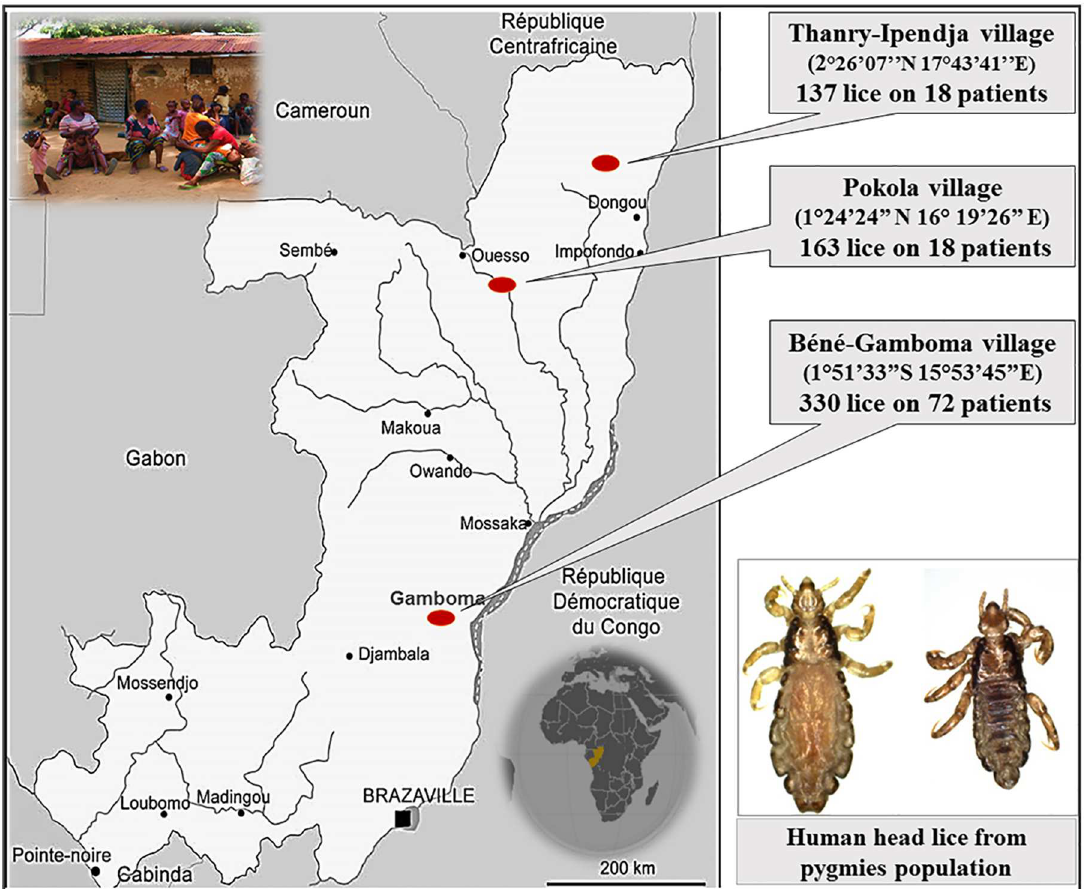
Fig 1. Map of head lice collection in the pygmy population from Congo-Brazzaville.